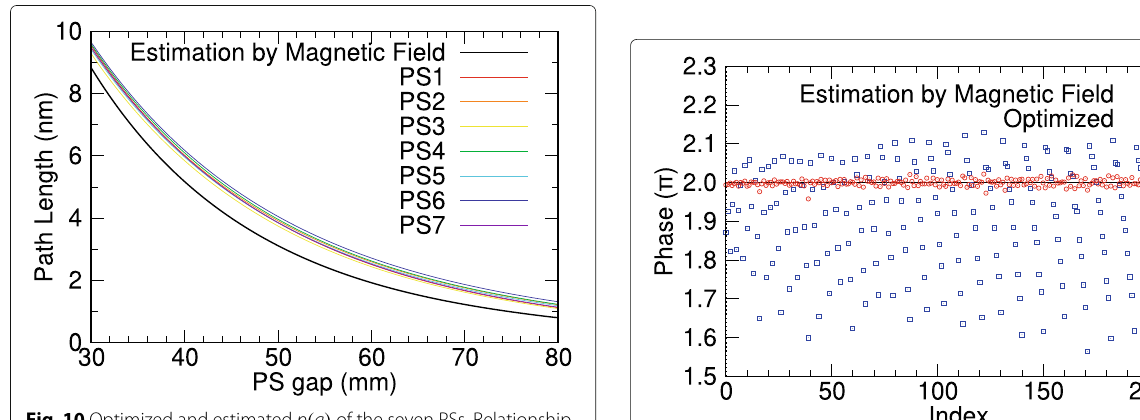
Fig. 10 Optimized and estimated p ( g ) of the seven PSs. Relationship between gap and path length in PMPSs. The black line indicates the estimated p ( g ) from the magnetic field measurements, and colored lines are optimized p ( g )